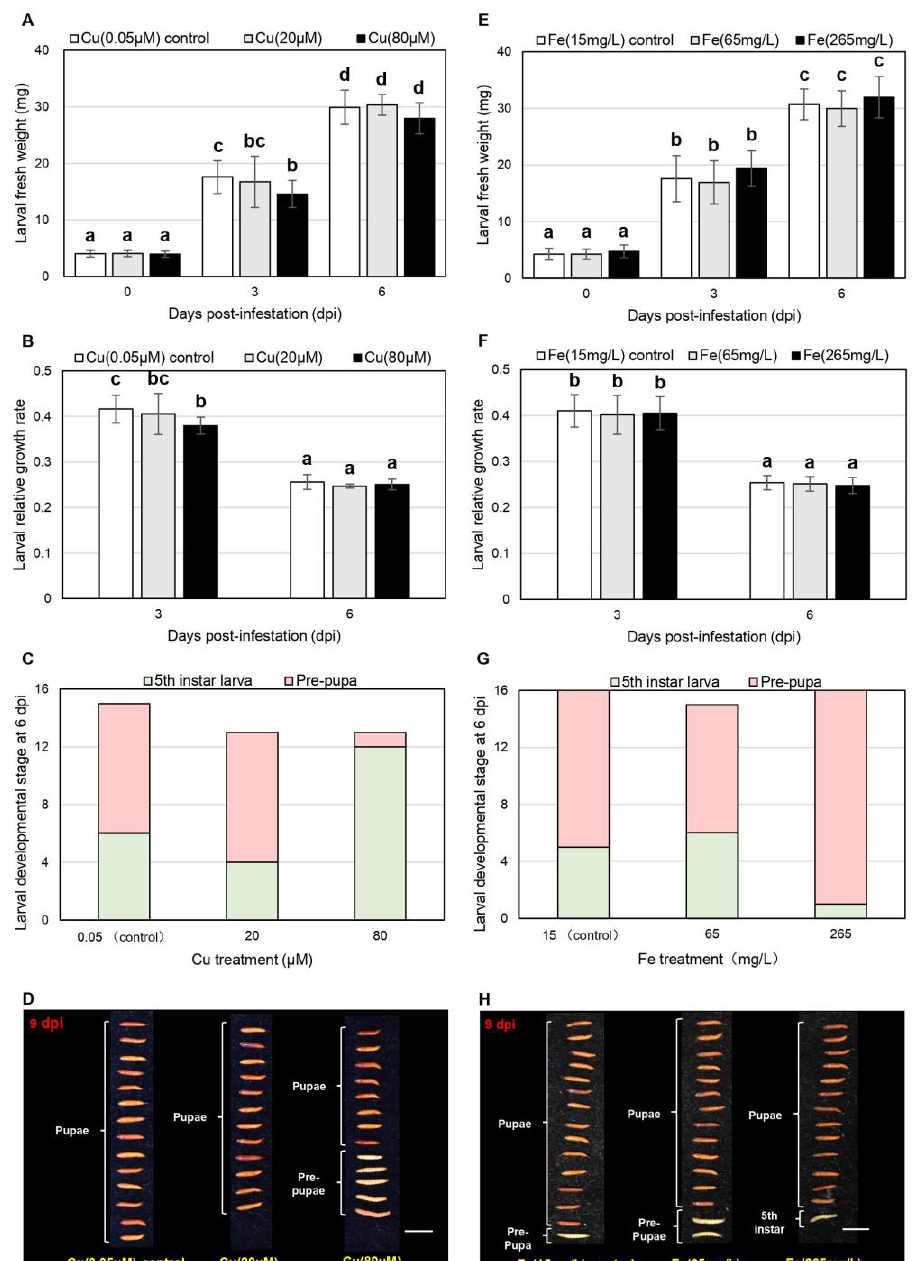
Figure 1. Effects of Cu and Fe treatments on C. medinalis growth and development at 3, 6 and 9 days post-infestation (dpi): ( A ) Larval fresh weight (FW) at 0, 3 and 6 dpi; ( B ) larval relative growth rate (RGR) at 3 and 6 dpi; ( C , D ) developmental stages of C. medinalis at ( C ) 6 dpi and ( D ) 9 dpi (scale bar = 1 cm) under Cu treatments; ( E ) Larval FW at 0, 3 and 6 dpi; ( F ) larval RGR at 3 and 6 dpi; developmental stages of C. medinalis at ( G ) 6 dpi and ( H ) 9 dpi (scale bar = 1 cm) under Fe treatments. Data are means ± SD (larval FW, n = 12–16; larval RGR, n = 9–16; developmental stages, n = 12–16). Two-way ANOVA and Tukey’s post hoc test were used for FW and RGR measurements, with different letters denoting a significant difference ( p < 0.05).